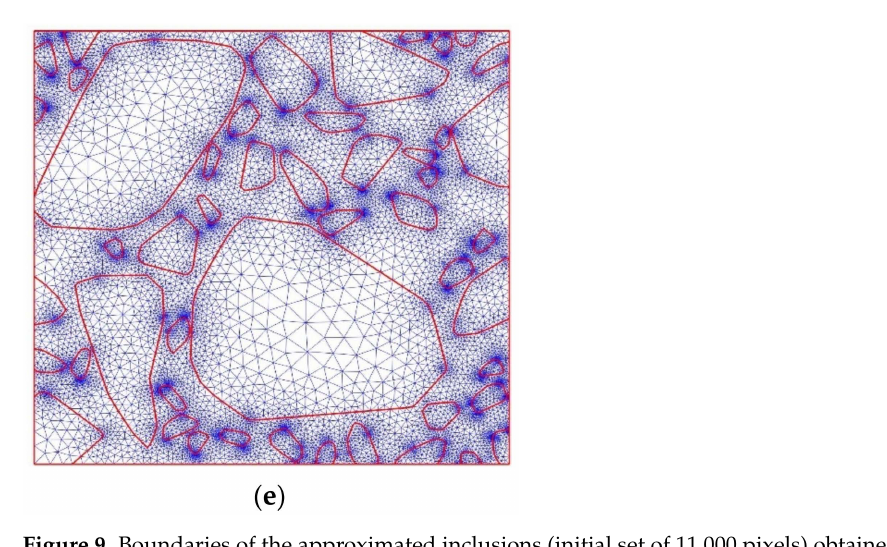
Figure 9. Boundaries of the approximated inclusions (initial set of 11,000 pixels) obtained by convex polygons ( a ) and their 860 vertices ( b ). Badly fitted convex area ( c ) corrected by inserting the additional vertex ( d ) and the fine mesh ( e ) corresponding to ( b )—including correction shown in ( d